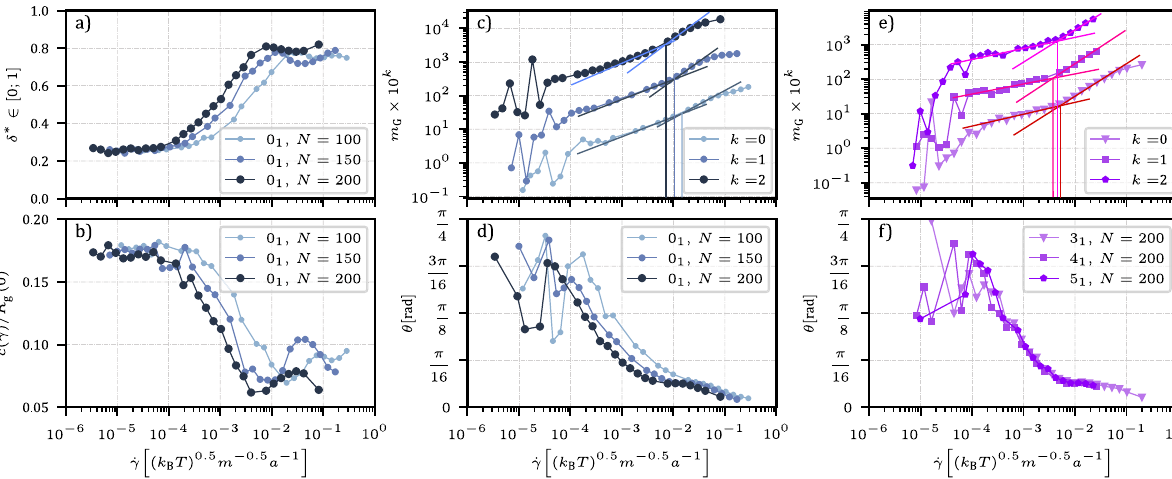
Fig. 2 Shape and orientation of knotted and unknotted ring polymers under increasing shear rate. a Anisotropy δ * . b Acylindricity c ð _ γ Þ scaled over the squared gyration radius at _ γ ¼ 0. c Orientational resistance m G for three different 0 1 rings, as denoted in the label of panel d . The vertical lines denote crossovers from the tumbling regime at the lower values of _ γ to the in fl ation regime at higher ones. The straight lines on the left of the crossover have slope 0.6 and the ones on the right have slope 0.85 for N = 100 and unity for N = 150 and N = 200. Curves have been multiplied by constants, providing vertical shifts as indicated in the label. d Alignment angle θ between the eigenvector corresponding to the largest eigenvalue of the gyration tensor and the fl ow axis for the three 0 1 rings. e Orientational resistance m G for three different knotted rings of topologies as denoted in the label of panel f . The straight lines on the left of the crossover points have slope 0.6, and the ones on the right have slope unity. The curves have been multiplied by constants, whose values are given in the label, for visual clarity. f Same as panel d , but for the three knotted rings whose characteristics are summarised in the